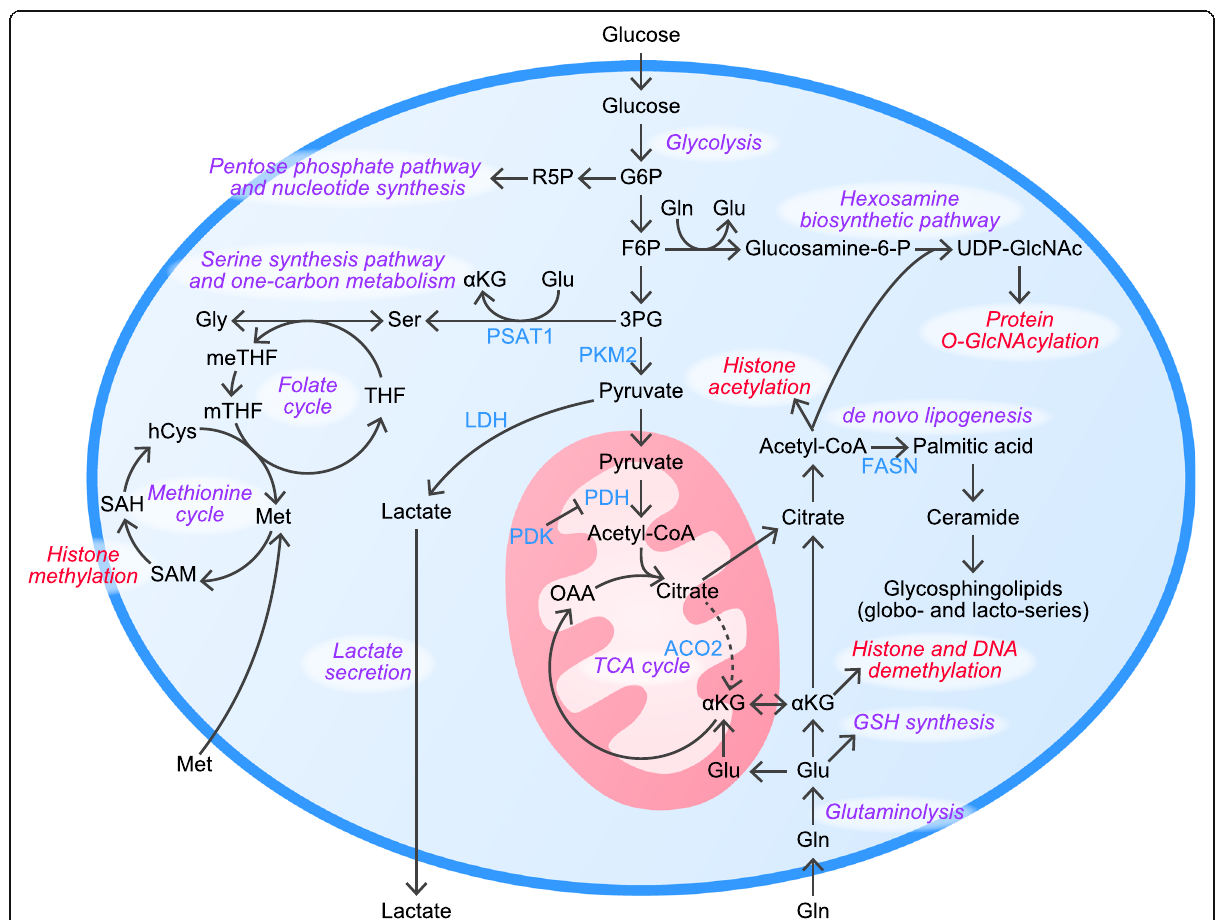
Fig. 1 Metabolic features of hPSCs. hPSCs consume glucose for glycolysis, nucleotide synthesis, nonessential amino acid synthesis, and hexosamine biosynthesis. The hexosamine pathway produces UDP-GlcNAc, which serves as a substrate for protein O-GlcNAcylation. The entry of pyruvate into the TCA cycle is inhibited by reduced activity of PDH by PDK. Pyruvate is reduced to lactate to replenish nicotinamide adenine dinucleotide (NAD + ) to maintain glycolytic activity. Pyruvate, which enters the mitochondrial matrix, is converted to acetyl-CoA and is utilized for citrate production. In hPSCs, the TCA cycle enzyme aconitase 2 is downregulated and conversion into α KG is limited. Citrate transported to the cytosol is converted back to acetyl-CoA, which is used for histone acetylation, de novo fatty acid synthesis, and hexosamine biosynthetic pathway. Fatty acids are utilized for various complex lipids, including glycosphingolipids. To replenish the latter part of the TCA cycle (i.e., α KG to oxaloacetate), hPSCs consume glutamine. Glutamine also plays a key role in glutathione synthesis, the hexosamine biosynthetic pathway, and the serine synthesis pathway. α -KG is required for histone and DNA demethylation. mPSCs consume threonine to produce SAM, but because threonine dehydrogenase is a pseudogene in hPSCs, hPSCs consume methionine to produce SAM. SAM is used for histone methylation. α KG, α - ketoglutarate; ACO2, aconitase 2; F6P, fructose 6-phosphate; FASN, fatty acid synthase; G6P, glucose 6-phosphate; Gln, glutamine; Glu, glutamate; Glucosamine-6-P, glucosamine-6-phosphate; Gly, glycine; GSH, glutathione; hCys, homocysteine; LDH, lactate dehydrogenase; Met, methionine; meTHF, 5,10-methylenetetrahydrofolate; mTHF, 5-methyltetrahydrofolate; PDH, pyruvate dehydrogenase; PDK, pyruvate dehydrogenase kinase; PKM2, pyruvate kinase M2; PSAT1, phosphoserine aminotransferase 1; R5P, ribose 5-phosphate; SAH, S -adenosyl homocysteine; SAM, S -adenosyl methionine; Ser, serine; TCA cycle, tricarboxylic acid cycle; THF, tetrahydrofolic acid; UDP-GlcNAc, uridine diphosphate